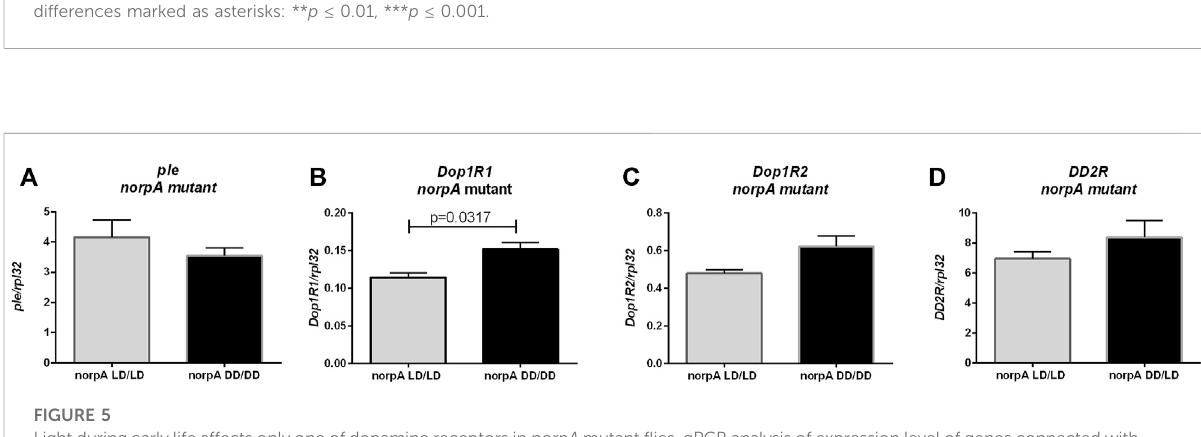
Light during early life affects only one of dopamine receptors in norpA mutant fl ies. qPCR analysis of expression level of genes connected with dopamine signaling for fl ies maintained in normal conditions LD12:12 (LD/LD), maintained and developed in darkness (DD/DD). Expression